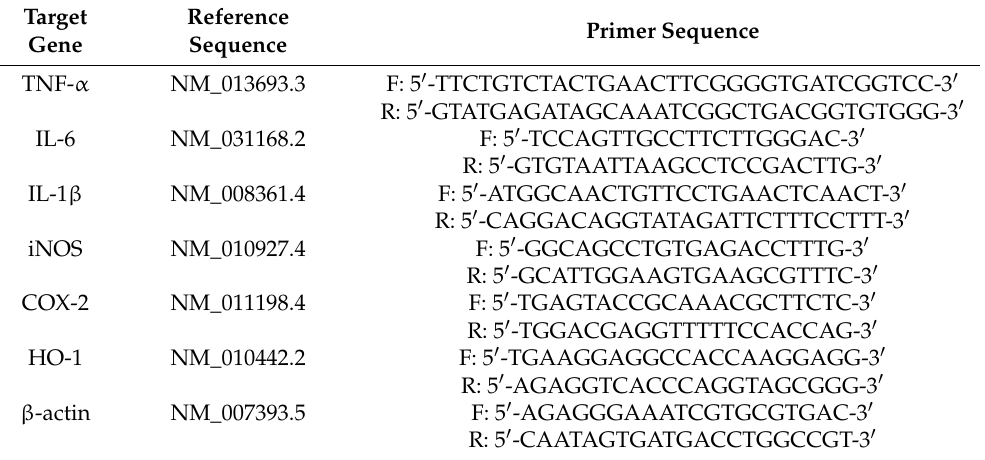
Table 2. Primers used for